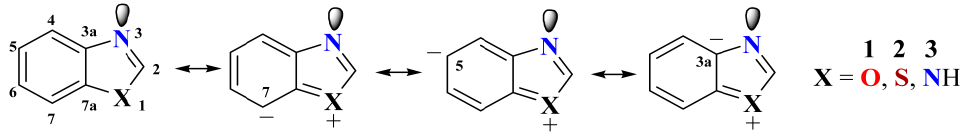
observed values in the solid state (CPMAS), at 119.9 and 112.2 ppm, respectively [4]. Within the above exposed background and the analysis of reported 13 C-NMR data, herein, we expose the usefulness of C4 and C7 chemical shifts as a criterion to estimate the position of the tautomeric equilibrium in